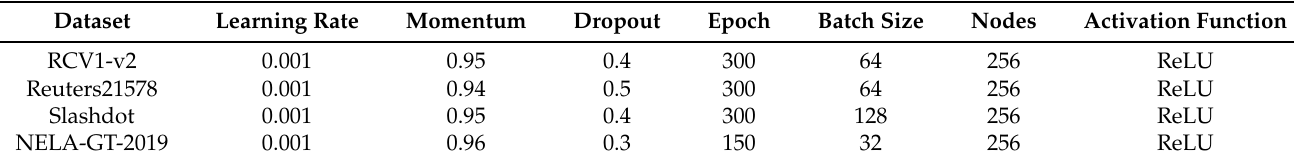
Table 4. Best values of hyperparameters of